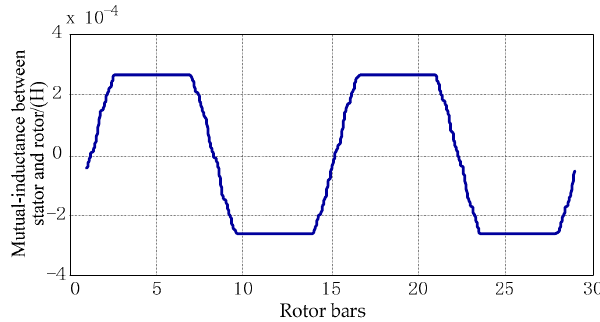
Figure 8. Mutual inductance between the stator and the rotor loop.